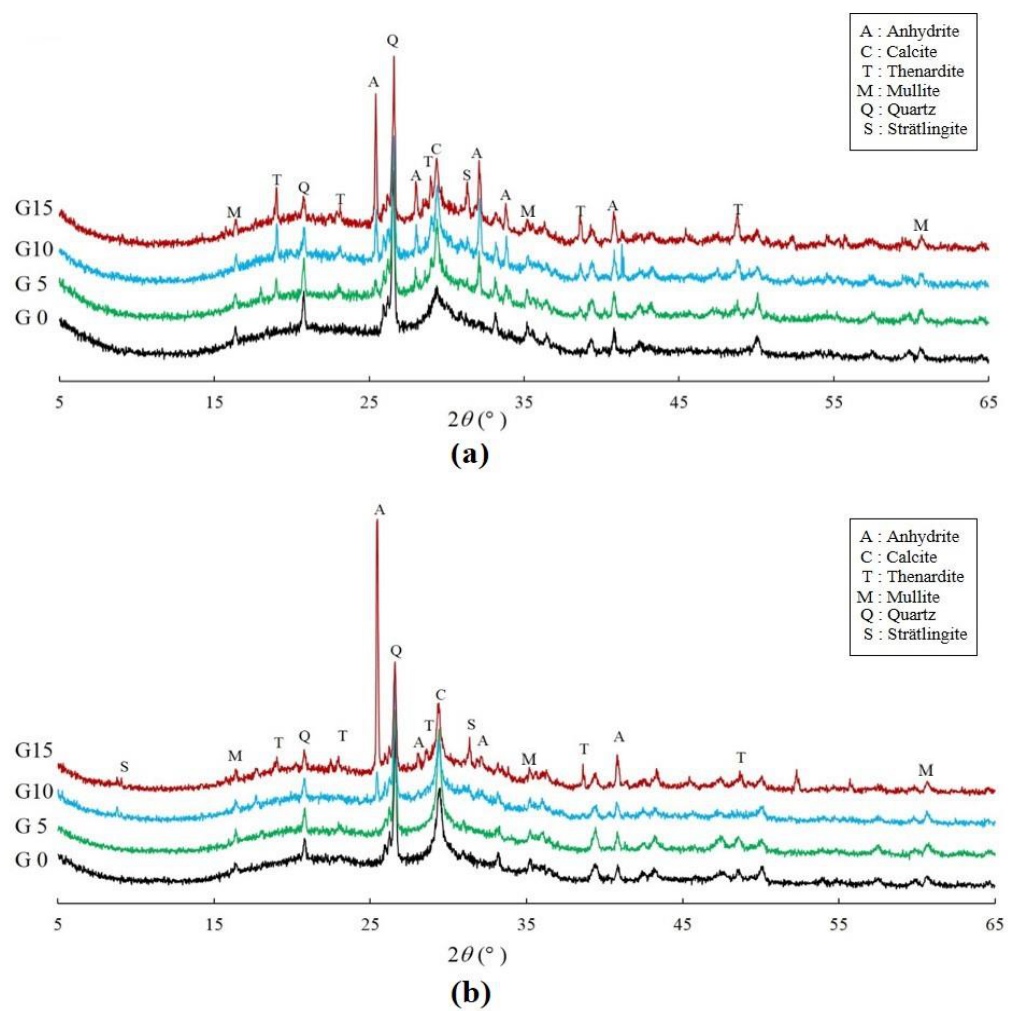
Figure 4. X-ray di ff raction (XRD) patterns of the specimens on the ( a ) 7th day and ( b ) 28th Figure 4. X-ray diffraction (XRD) patterns of the specimens on the ( a ) 7th day and ( b ) 28th day.